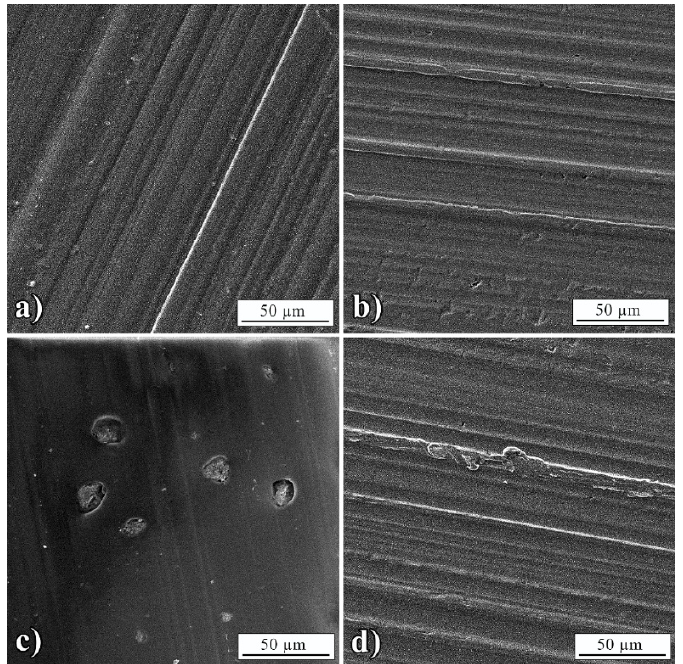
Figure 5. FE-SEM micrographs of: ( a ) Peeled BT interface with L3005, ( b ) L3005 interface after removing BT, ( c ) peeled BT+5 wt.% Mn-Al LDH interface, and ( d ) L3005 interface after removing BT+5 wt.% Mn-Al LDH.